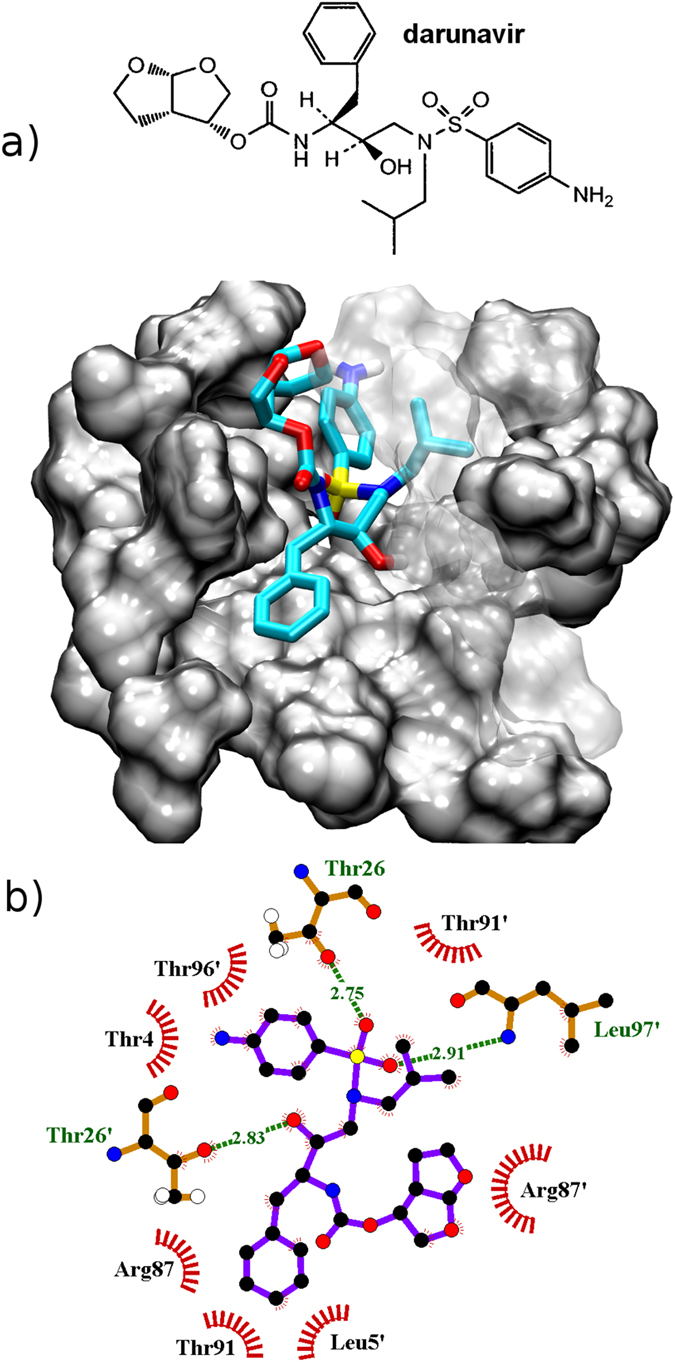
(a) Binding of darunavir to the new pocket in conformation S2C. (b) Darunavir interactions with the binding site represented employing the software Ligplot+60.